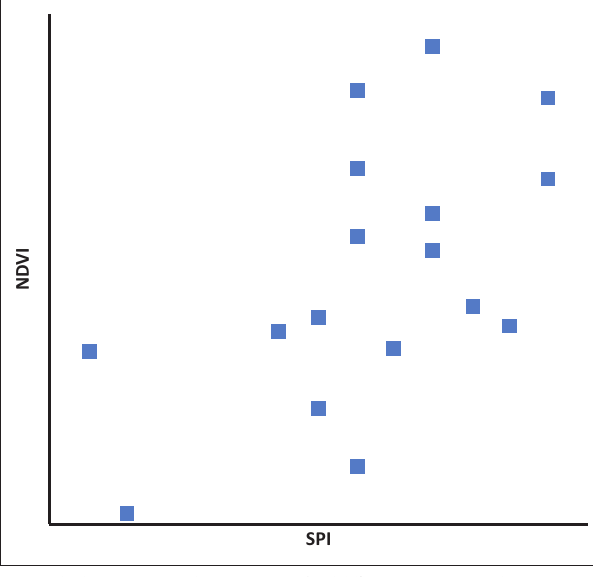
FIGURE 4: Correlation coefficient scatterplots for standardised precipitation index-3 time scale.